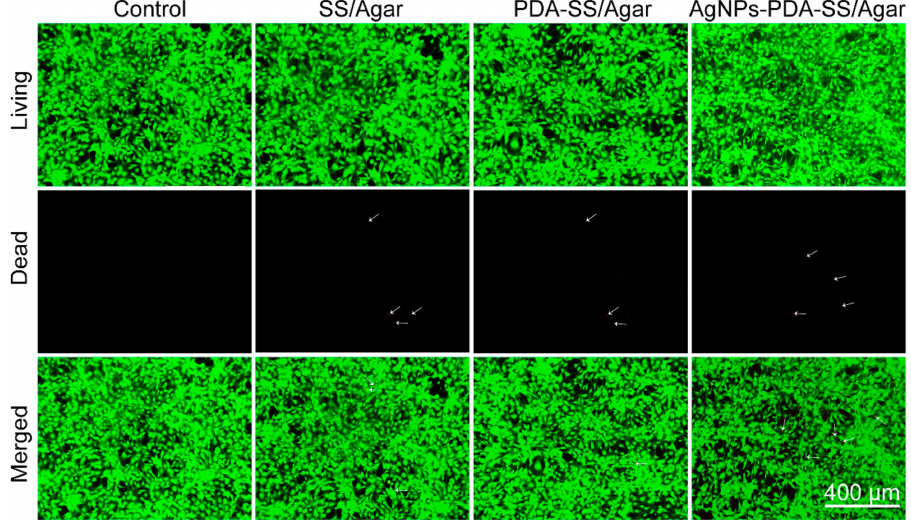
Figure 11. Living/dead cell staining assay of NIH/3T3 cells after being treated with different films. White arrows indicate a very few cells (<1 ‰ ) were stained